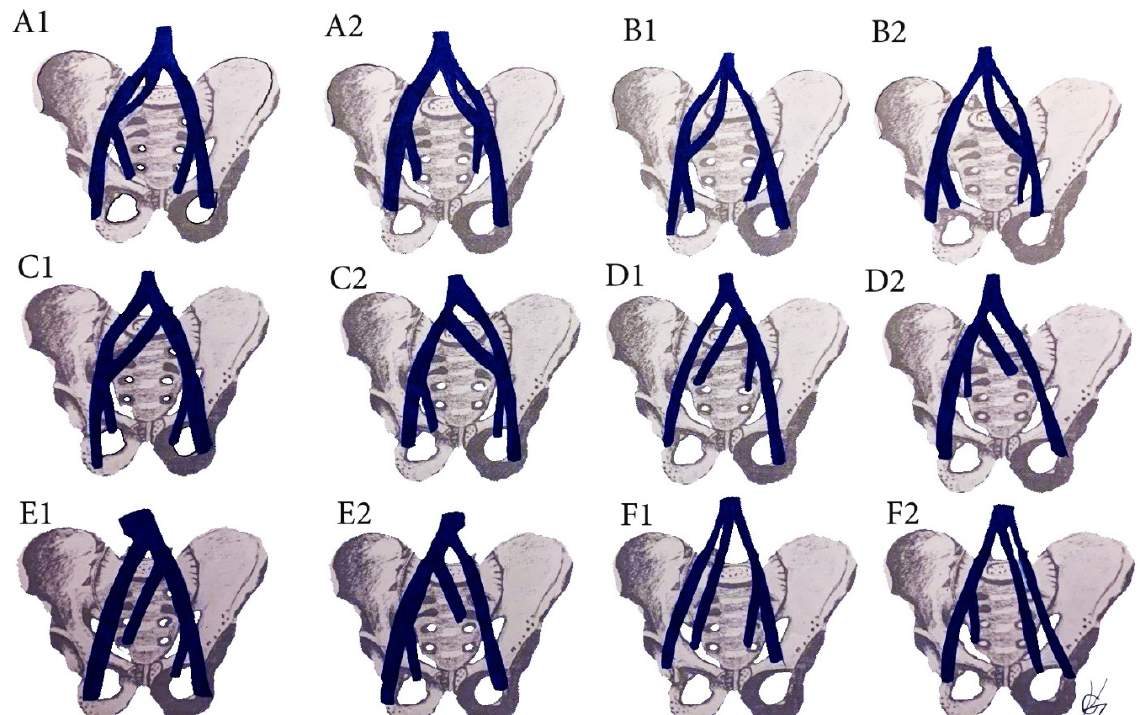
Figure 13. Common iliac vein variations. ( A ) Incomplete duplication of the CIV; ( B ) complete duplication of the CIV; ( C ) lateral duplicated branch drains into the IVC, the medial drain into the CIV. ( D ) Absent CIV, external and internal iliac veins drain to the contralateral CIV; ( E ) absent CIV, the EIV drains into the IVC, the IIV drains into the contralateral CIV; ( F ) Absent CIV, the external and internal veins drain into IVC. Inferior vena cava (IVC), Common iliac vein (CIV), external iliac vein (EIV), internal iliac vein (IIV). ( A1 , B1 , C1 , D1 , E1 , F1 ) are related to right hemipelvises variations, whereas ( A2 , B2 , C2 , D2 , E2 , F2 ) are related to left hemipelvises variations.